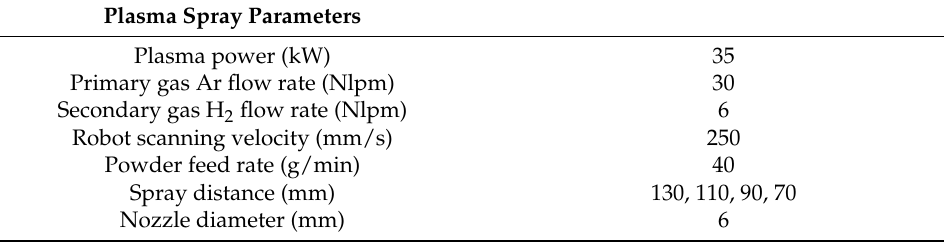
Table 2. Main spray